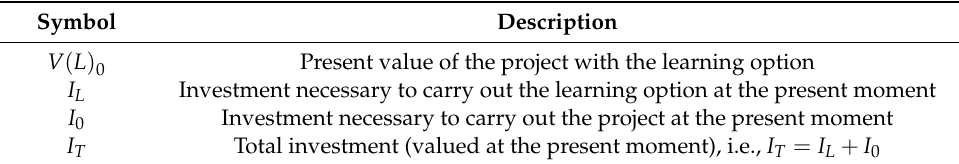
Table 1. List of notations (source: own